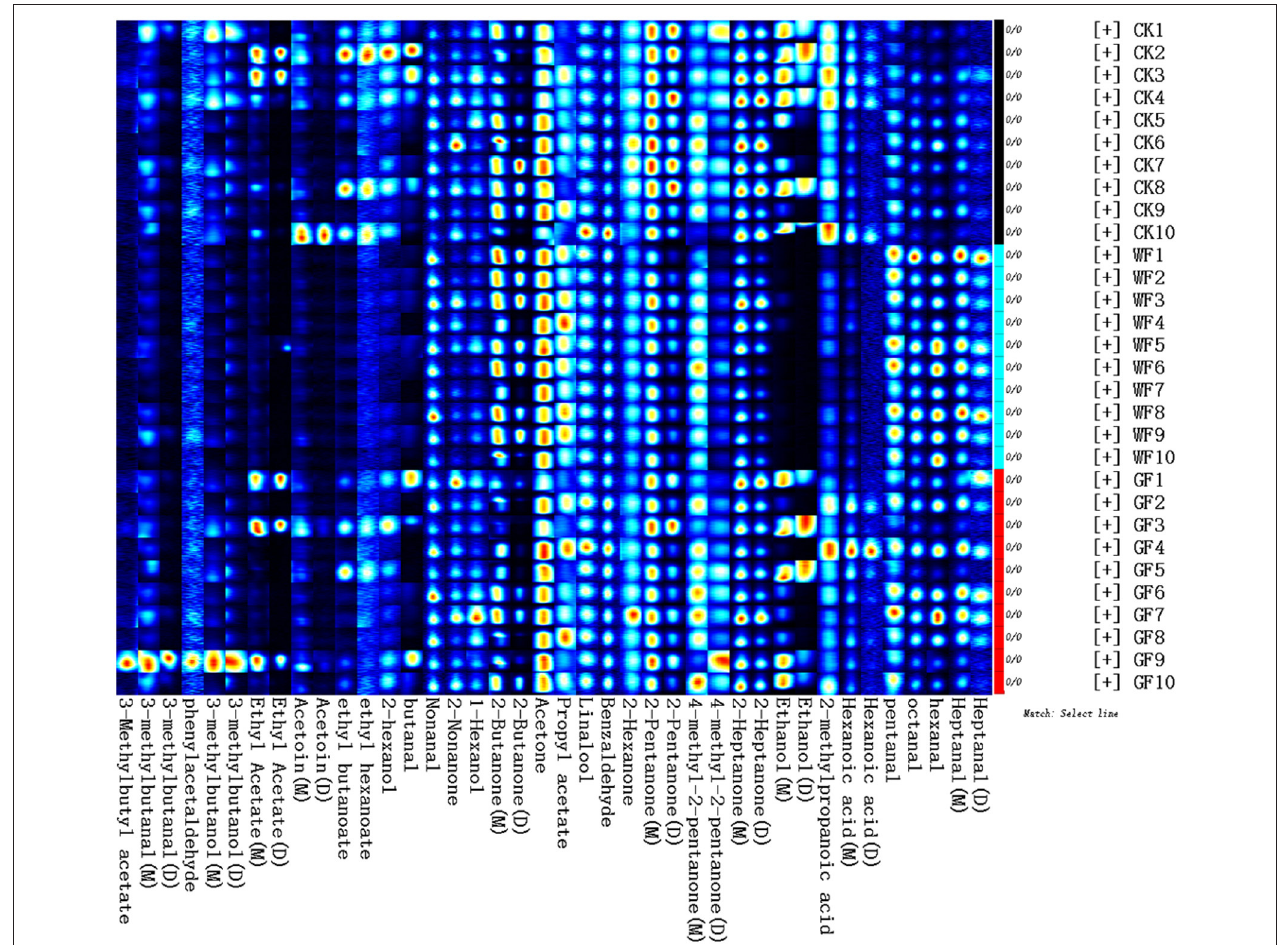
FIGURE 2 | Gallery Plot in raw milk from cows fed different diets. (M), Monomer; (D), Dimer. CK, dairy cows with a basal diet (without flaxseed); WF, whole flaxseed (dairy cows were fed whole flaxseed: 1,500 g/d per cow); GF, ground flaxseed (dairy cows were fed ground flaxseed: 1,500 g/d per cow).